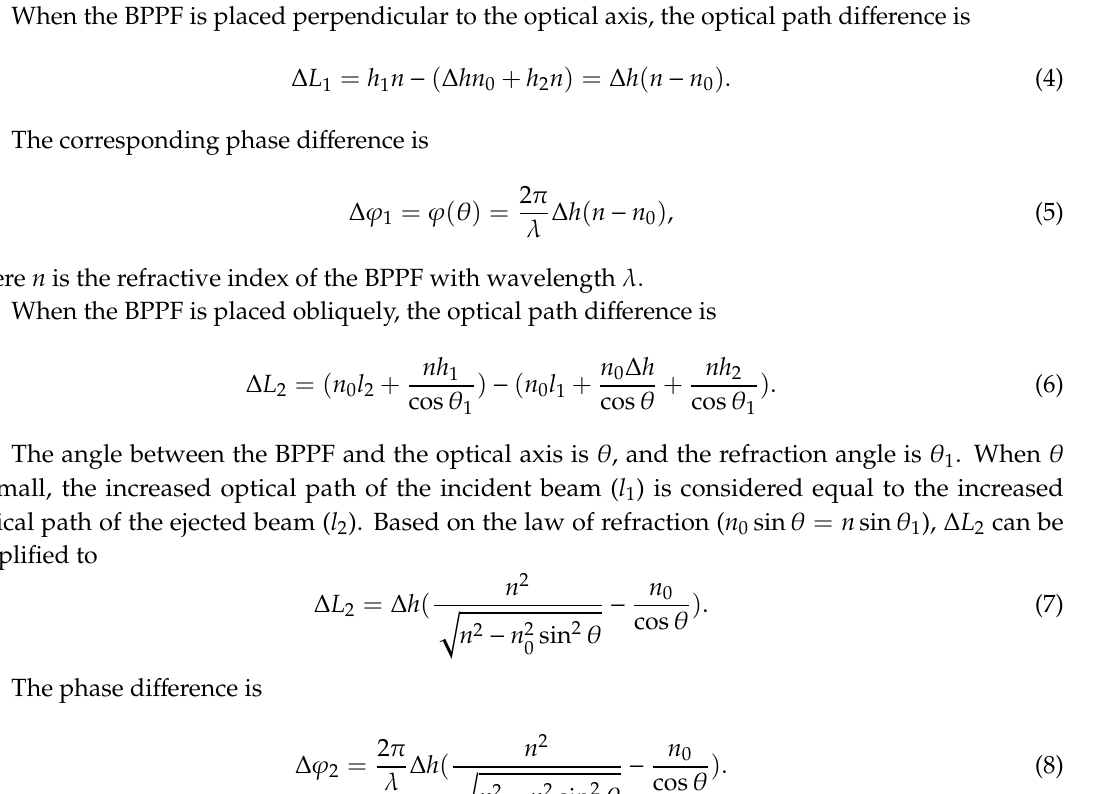
Figure 3. Microstructure diagrams of a BPPF placed ( a ) perpendicular and ( b ) oblique to the optical axis. IB: incident beam; EB: ejected beam.